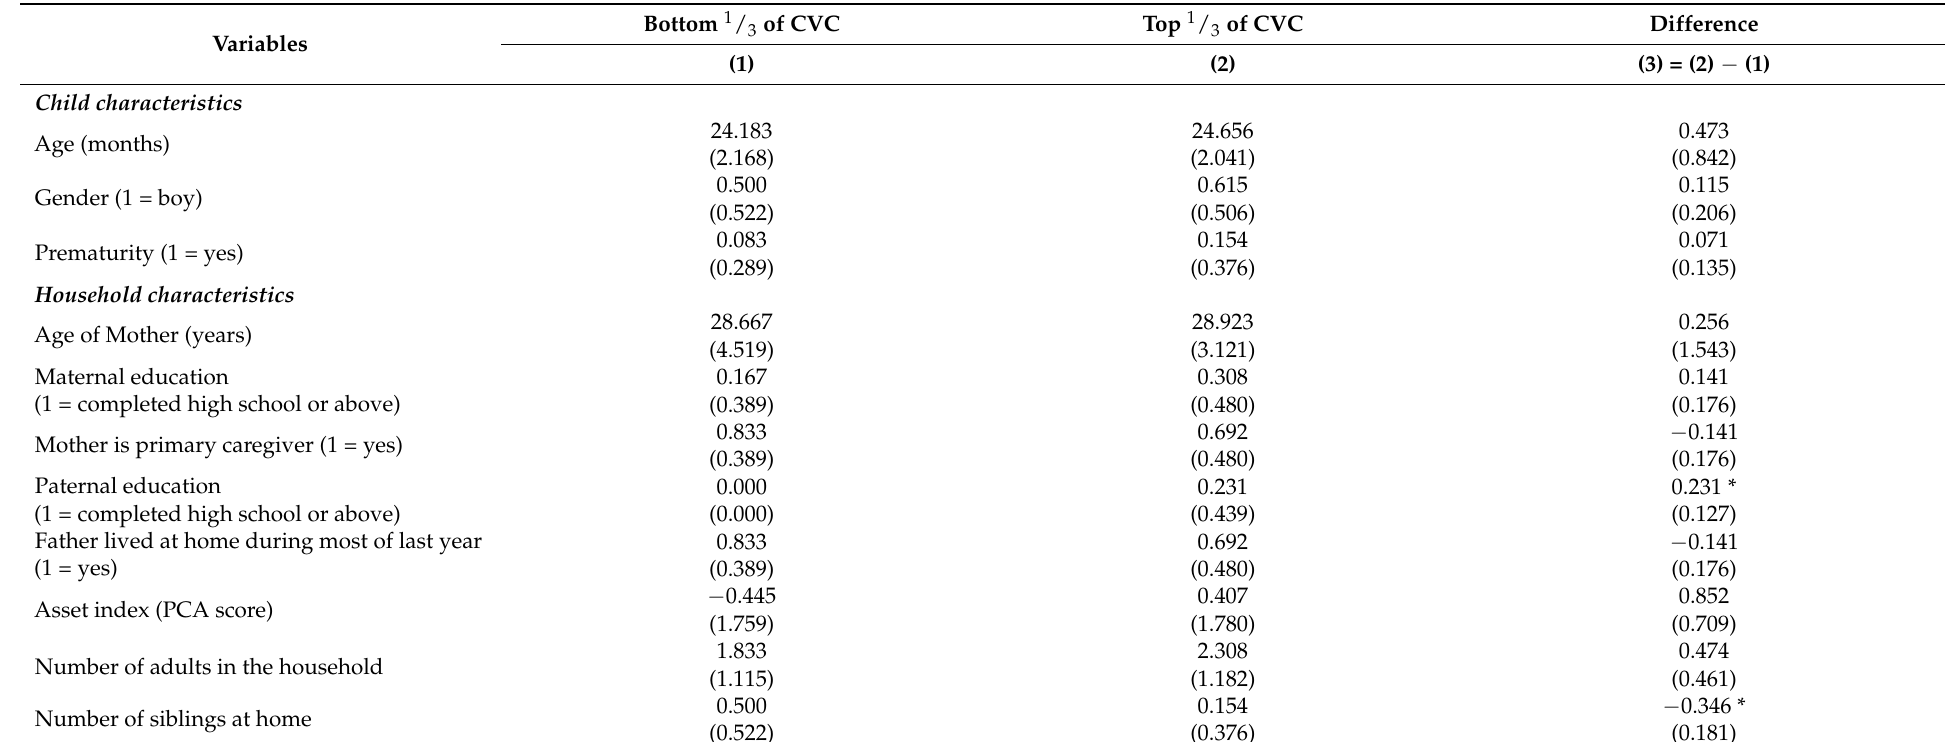
Table 4. Differences in characteristics between top and bottom terciles of Child Vocalizations Count (N =